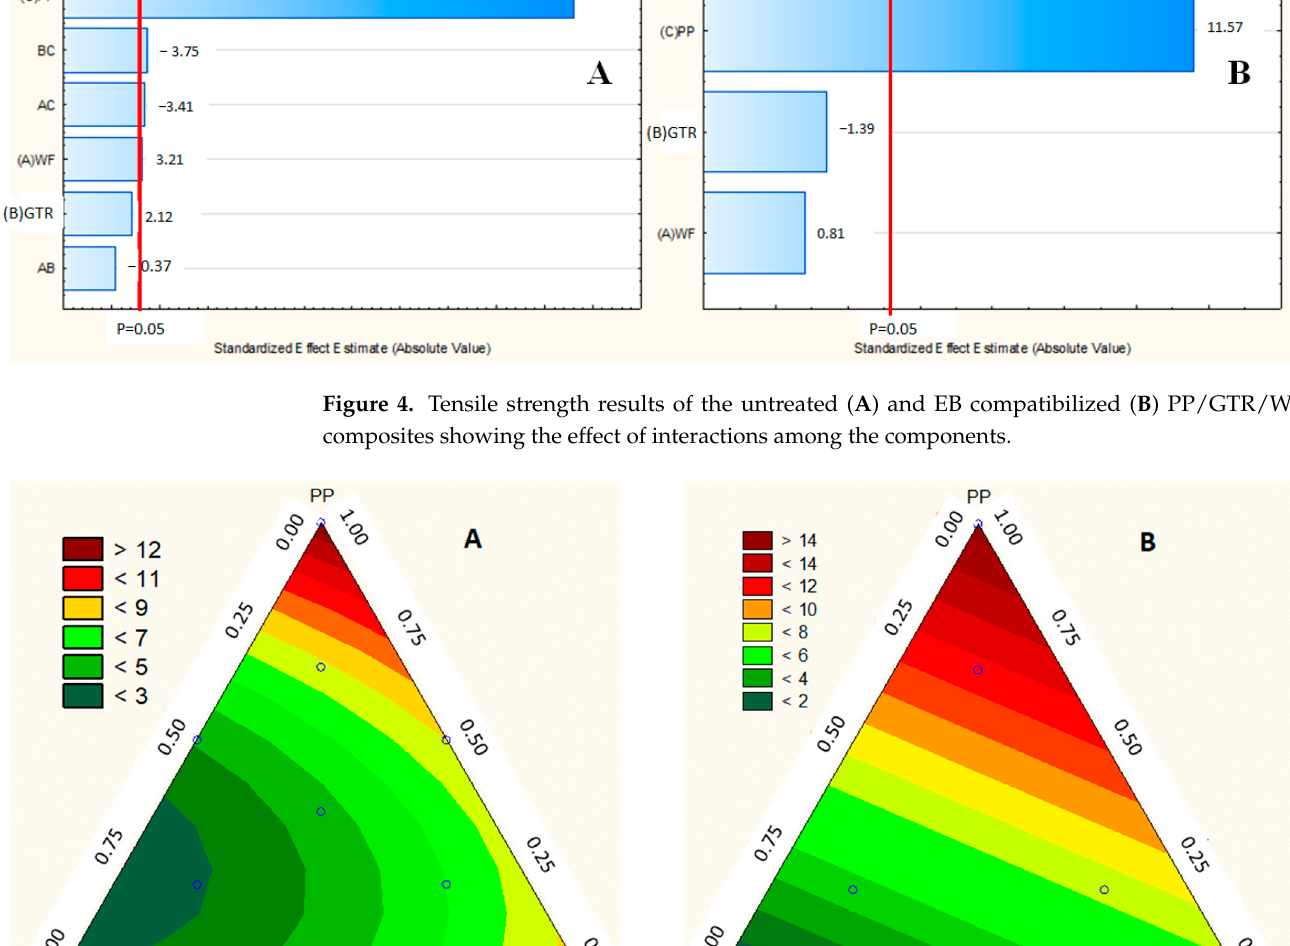
Figure 4. Tensile strength results of the untreated ( A ) and EB compatibilized ( B ) PP/GTR/WF composites showing the effect of interactions among the components.